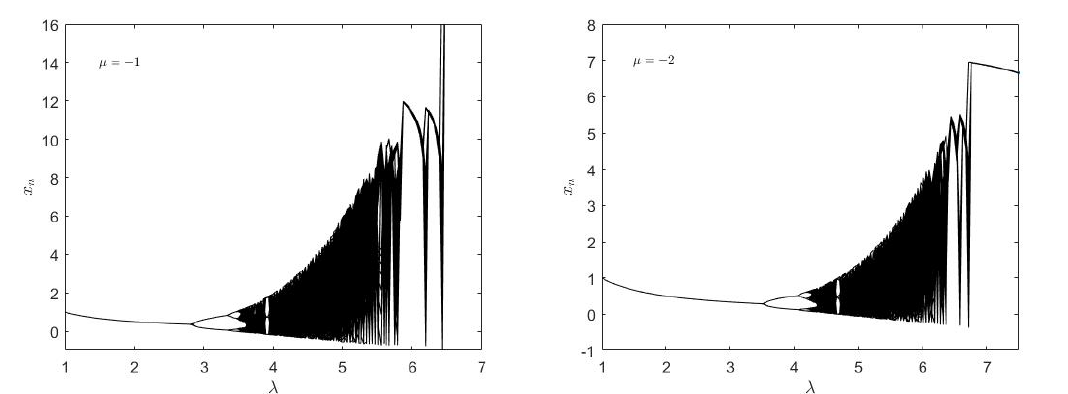
Figure 2. Bifurcation diagram for μ = − 1 Figure 3. Bifurcation diagram for μ = −